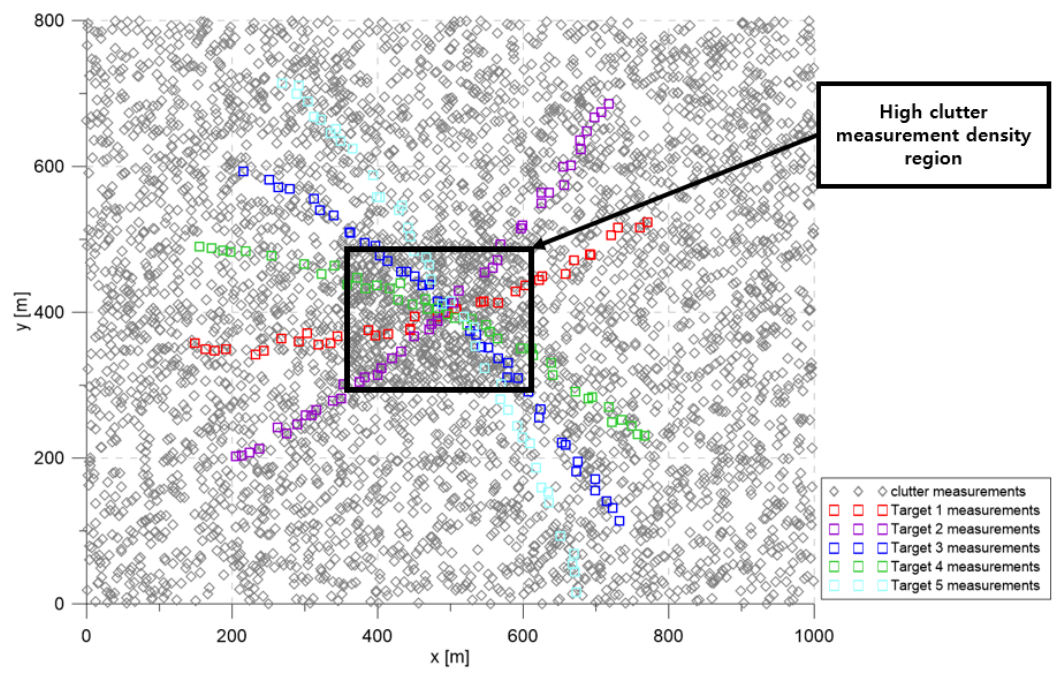
Figure 8. Simulation scenario with five targets.